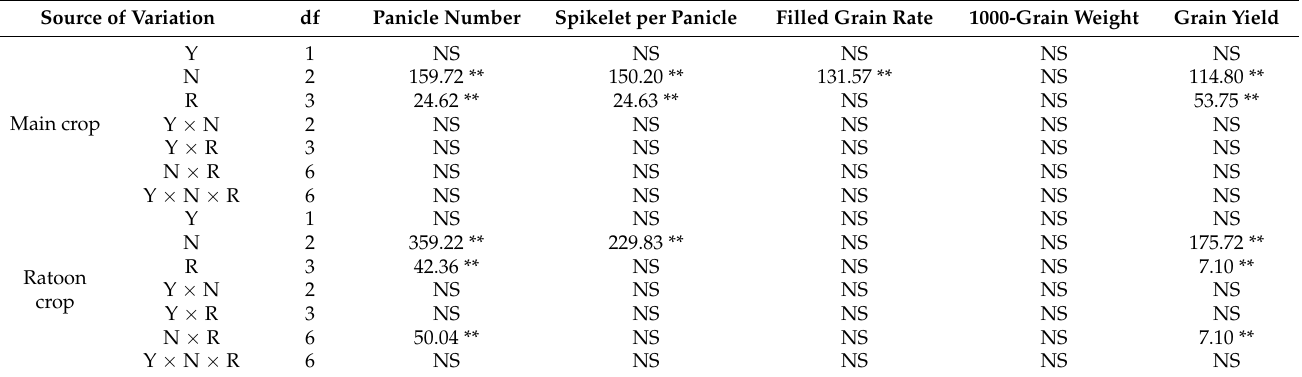
Table 2. Analysis-of-variance of F-values of the grain yield and yield components of the main and ratoon crops between/among years, N regimes.